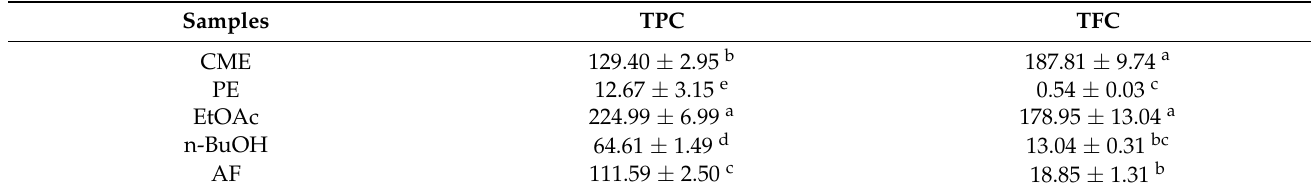
Table 1. The TPC and TFC values of M. lasiocarp extracts.